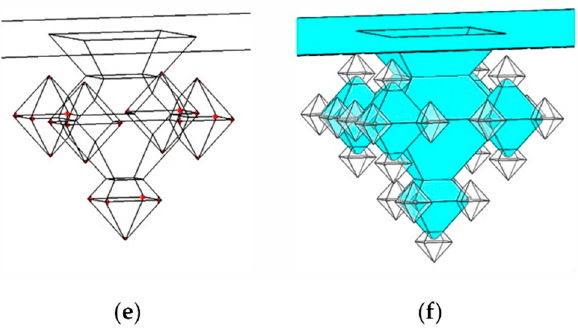
Figure 2. Schematic overview of the formation of 3D fractals using ( a ) inverted pyramid and applying corner lithography followed ( b ) by etching the masking layer and etching silicon to form next generation fractals. The steps are repeated to form second—( c , d ) and third—( e , f ) generation fractals.